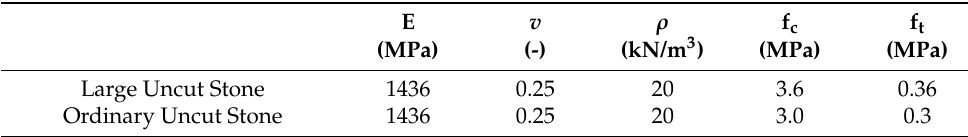
Figure 7. ( a ) FE and ( b ) DE models of the Santissimo Crocifisso Church in Pretare (Arquata del Tronto, AP). Table 1. Linear and nonlinear parameters of masonry.